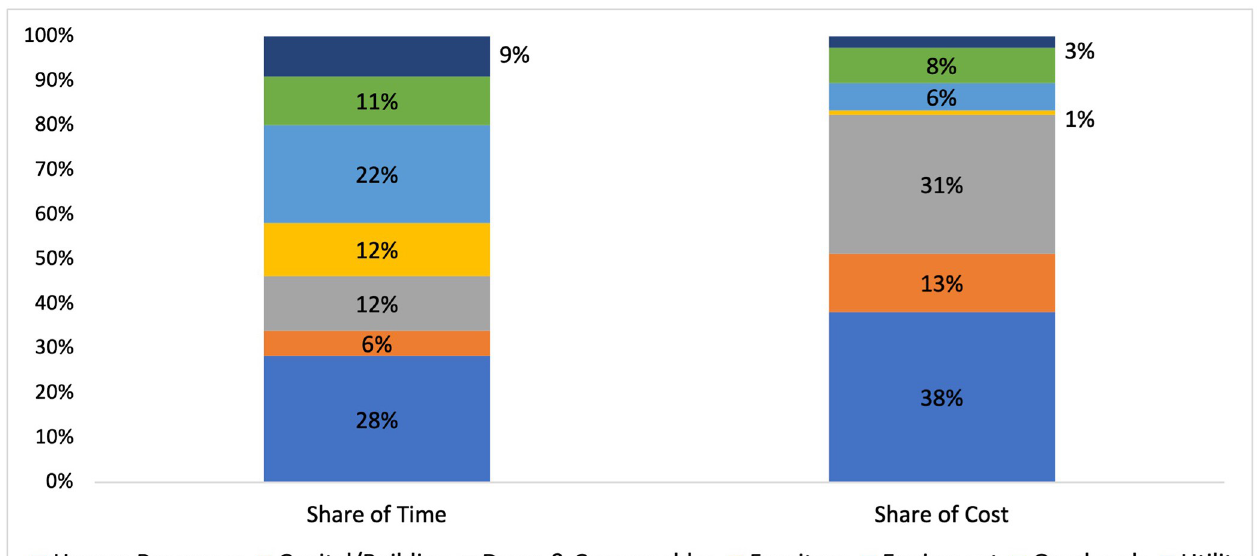
Fig 3. Percentage share of time and cost for each input